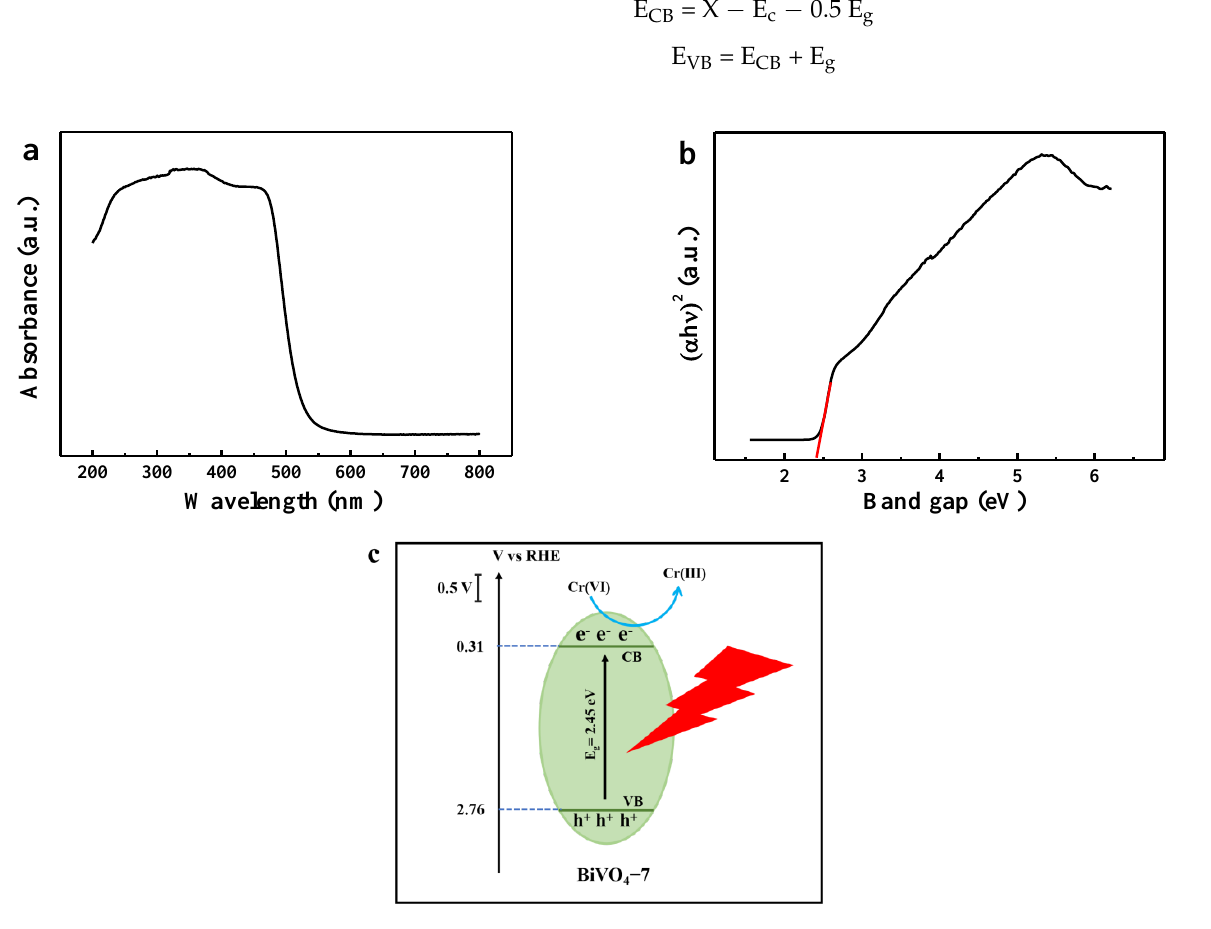
Figure 4. ( a ) UV-Vis diffuse reflectance spectra for BiVO 4 -7; ( b ) plots of ( α h ν ) 2 vs. the photon energy (h ν ) for BiVO 4 -7; ( c ) photoelectrochemical mechanism for Cr(VI) detection by BiVO 4 -7. E c denotes the energy of free electrons on the hydrogen scale. This value was ap- proximately 4.5 eV, and the electronegativity (X) of BiVO 4 was 6.035 eV [31]. The formula presented above was used to calculate the E CB and E VB of BiVO 4 -7 as 0.31 and 2.76